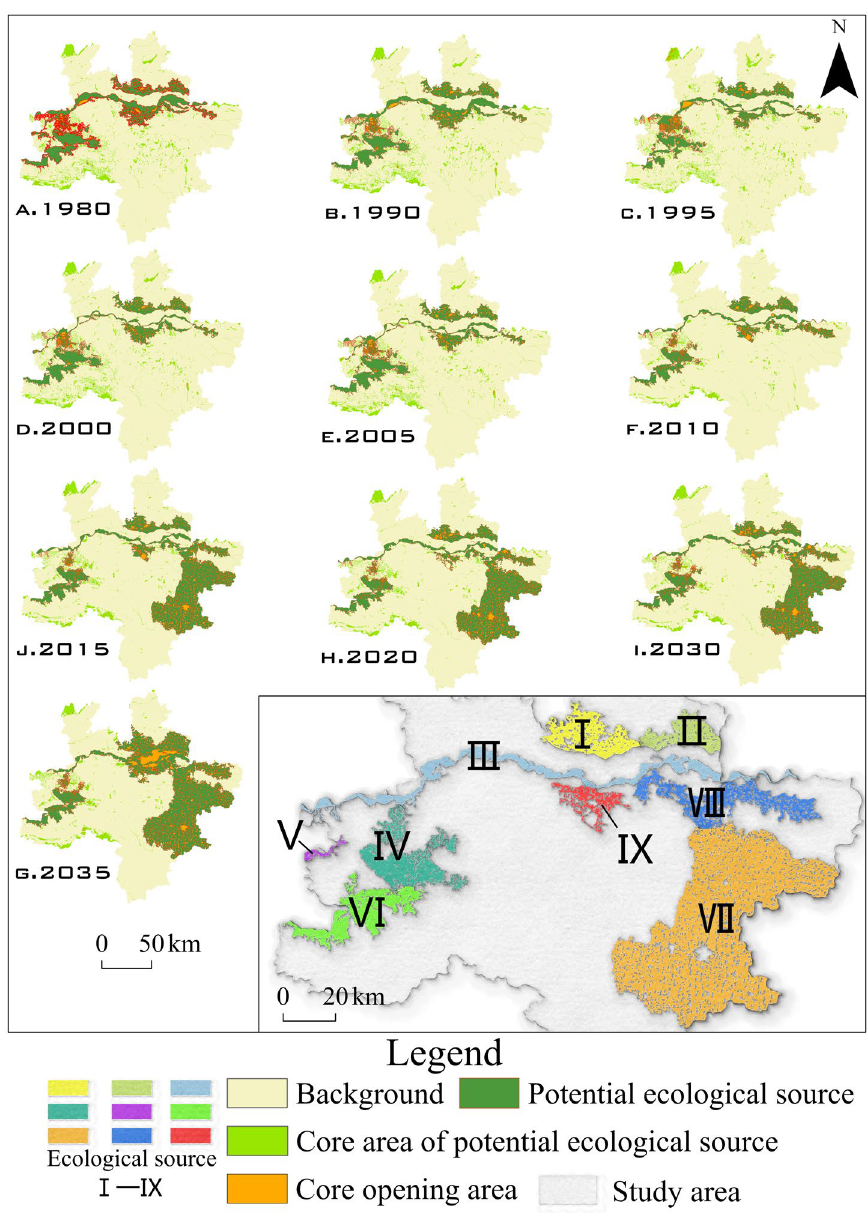
Figure 6. Ecological source identification using MSPA. Table 5. Land transfer matrix from 1980 to 2035.